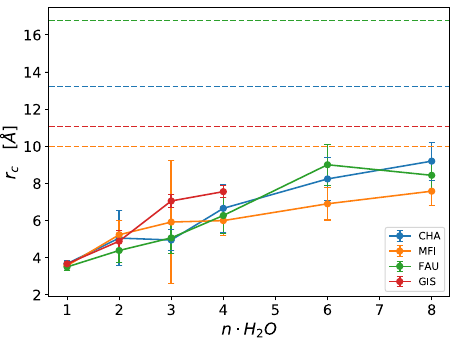
Fig. 9 Radii of spheres around the aluminum atoms enclosing the 90% of the water density. Dashed lines report the maximum Al-Si distances in the respective cavities which indicates the approximate diameters of the main channel or pore. Error bars report standard deviations of each